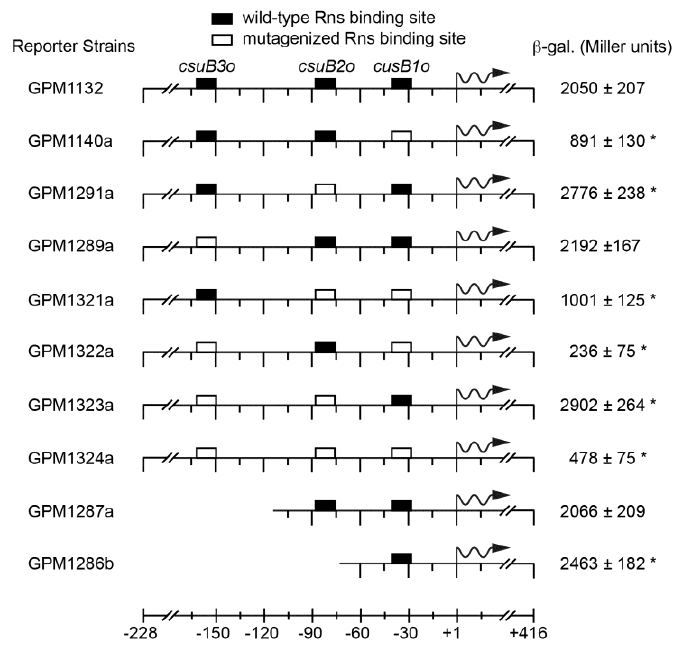
Figure 4. Analyses of Rns binding sites in vivo. Lac reporter strains were transformed with an Rns expression plasmid and the expression of β -galactosidase was quantified. Numbering is relative to the Rns-dependent transcription start site with wavy arrows indicating the direction of transcription. The average and standard deviation of Miller units are reported, n ≥ 3. * Statistically significant ( p ≤ 0.005) when compared to GPM1132. In the absence of Rns, each reporter strain produced ≤ 20 Miller